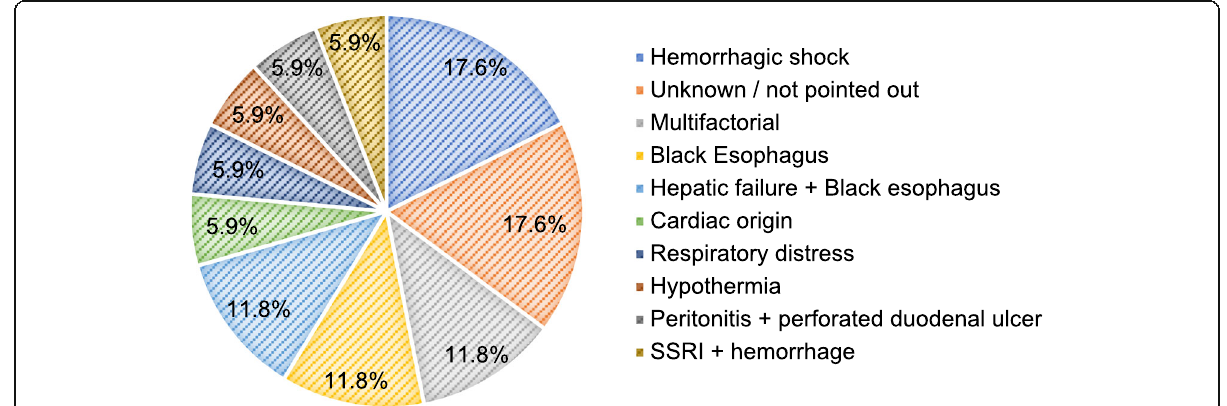
Fig. 5 Causes of death in autopsy series classified by their frequencies. SSRI selective serotonin receptor